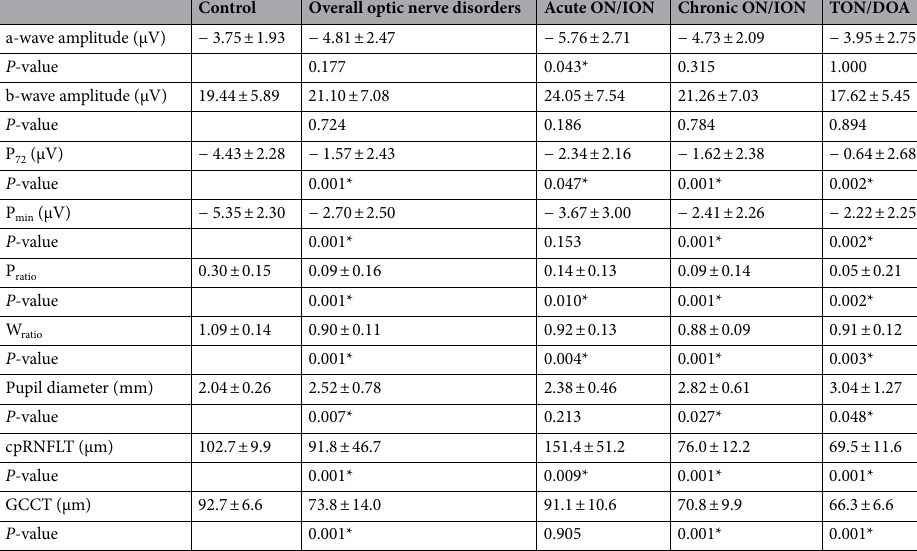
Table 2. ERGs and OCT for each group. cpRNFLT, circumpapillary retinal nerve fiber layer thickness; GCCT, ganglion cell complex thickness; ON, optic neuritis; ION, ischemic optic neuropathy; TON, traumatic optic neuropathy; DOA, dominant optic atrophy. Optic nerve disease groups were statistically compared with the control group. * P < 0.05 was considered significant. Data are shown as the mean ± standard deviation.